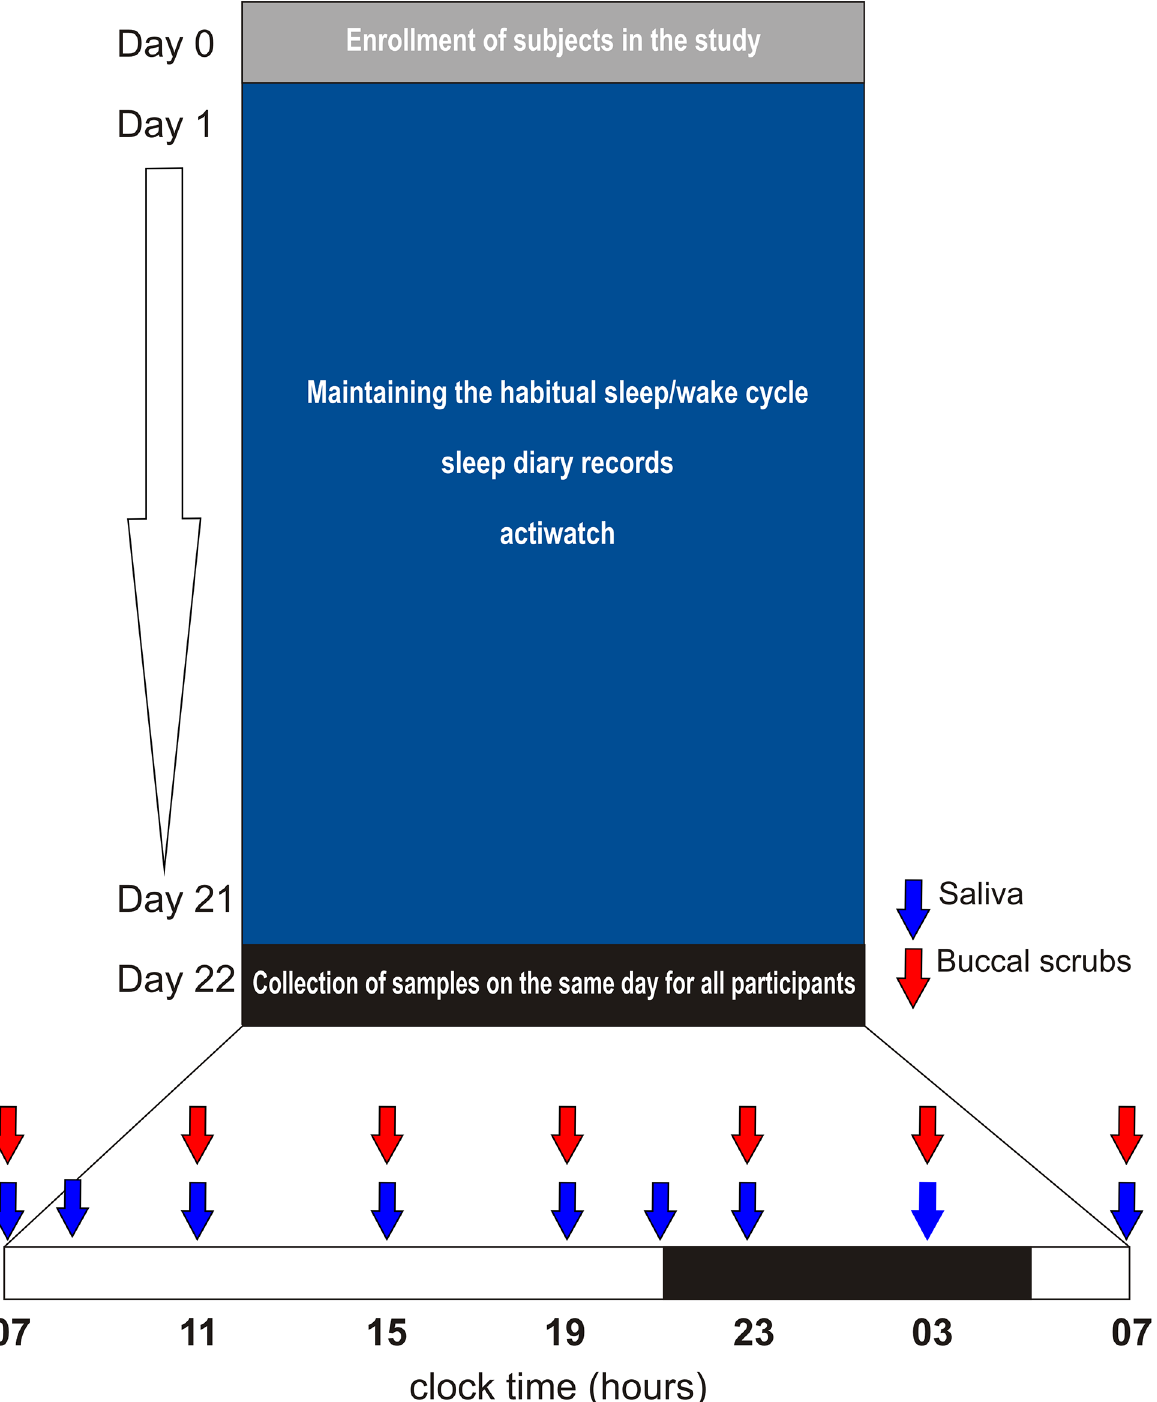
Fig 1. Protocol of the study. The study began (day 1) with recording of sleep/wake schedule in diaries (all participants) together with Actiwatch monitoring (4 couples) for 21 days. During the monitored period, the subjects maintained their habitual sleep/wake regime. Thereafter, the samples were collected throughout the 24 h on the same day from all subjects. Time when saliva (blue arrows) and buccal mucosa samples (red arrows) were collected is depicted. The dark bar on the time scale corresponds to hours between the sunset and the sunrise on the sampling day. For more details, see Materials and Methods.